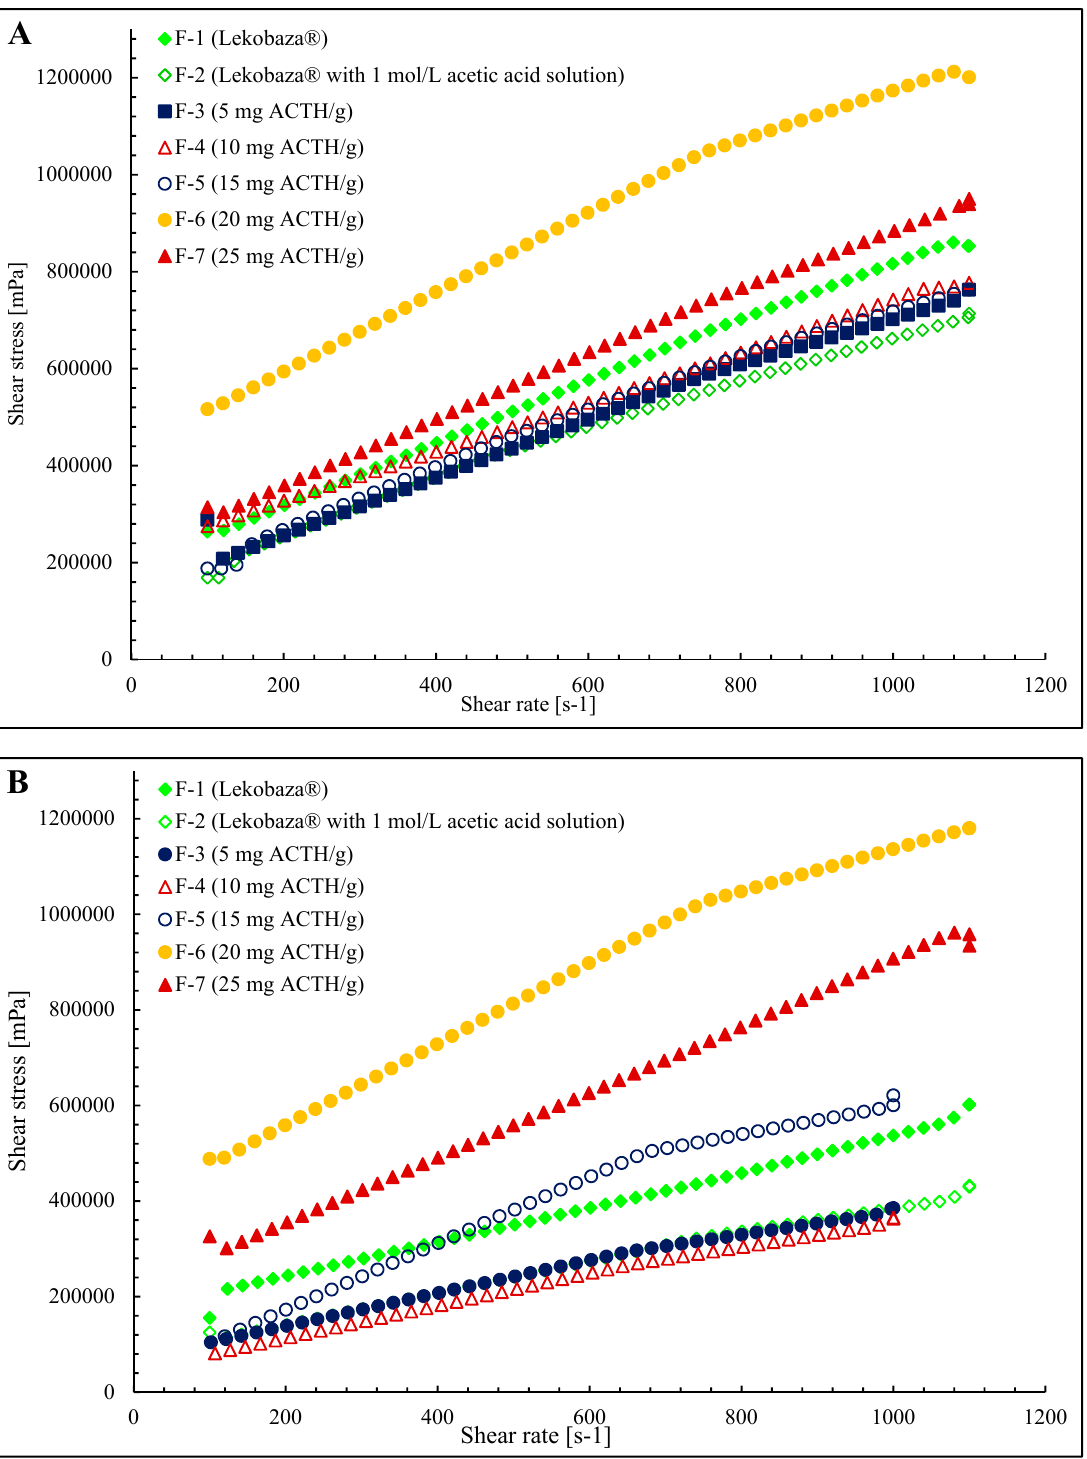
Figure 3. The flow curves of the investigated ointment formulations F-1–F-7 at 25 ( A ) and 32 °C ( B ).